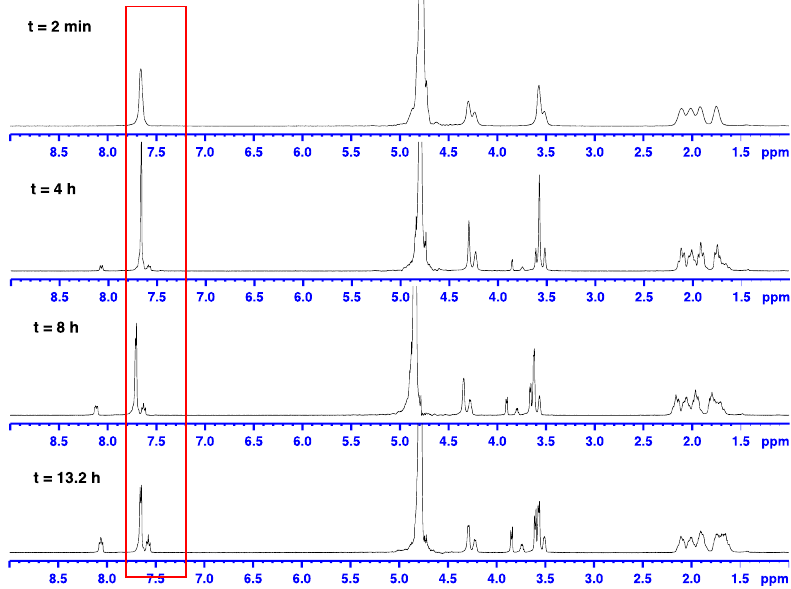
Figure 10. Progress of the hydrolysis of 5b in methanol- d 4 /D 2 O (1:1) at 70 °C, followed by 1 H-NMR; the intensity of amide peaks decreased, and new product signals appeared as the reaction progressed (red